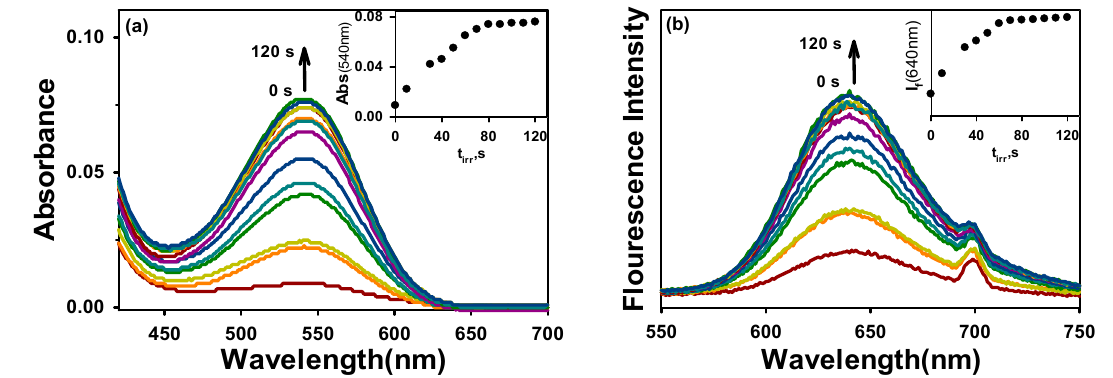
Figure 1. ( a ) Absorption and ( b ) fluorescence spectral changes of SP-IQ with irradiation time (0–120 s, Different color lines represent different irradiation times.) with UV irradiation at 350 nm. Inset: Plots of ( a ) absorbance at 540 nm and ( b ) fluorescence intensity at 640 nm vs . irradiation time.